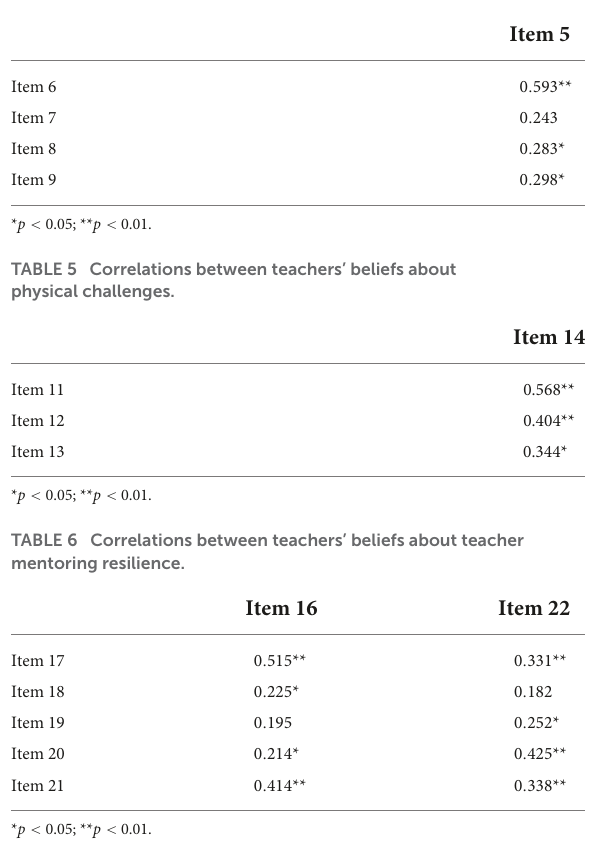
TABLE 7 Correlations between teacher mentoring resilience: Emotional vs. physical concerns.